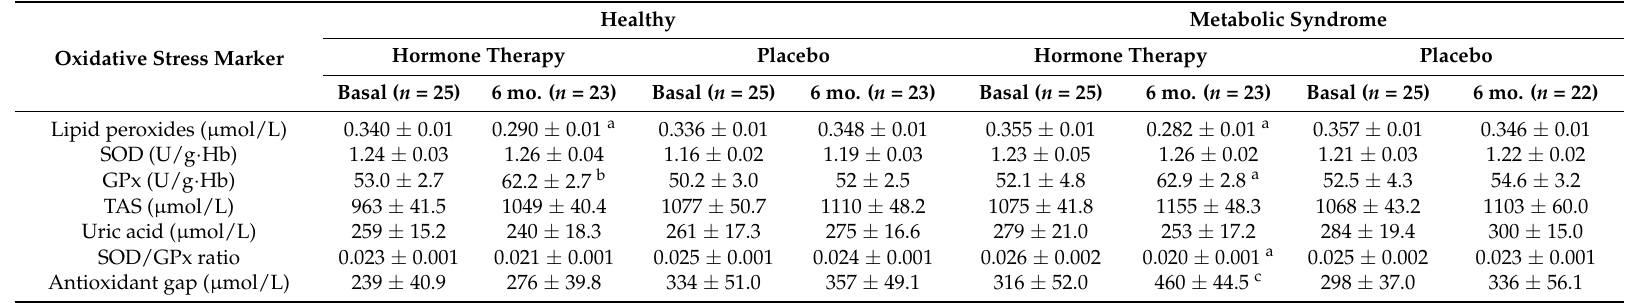
Table 4. Oxidative stress markers after 6 months of